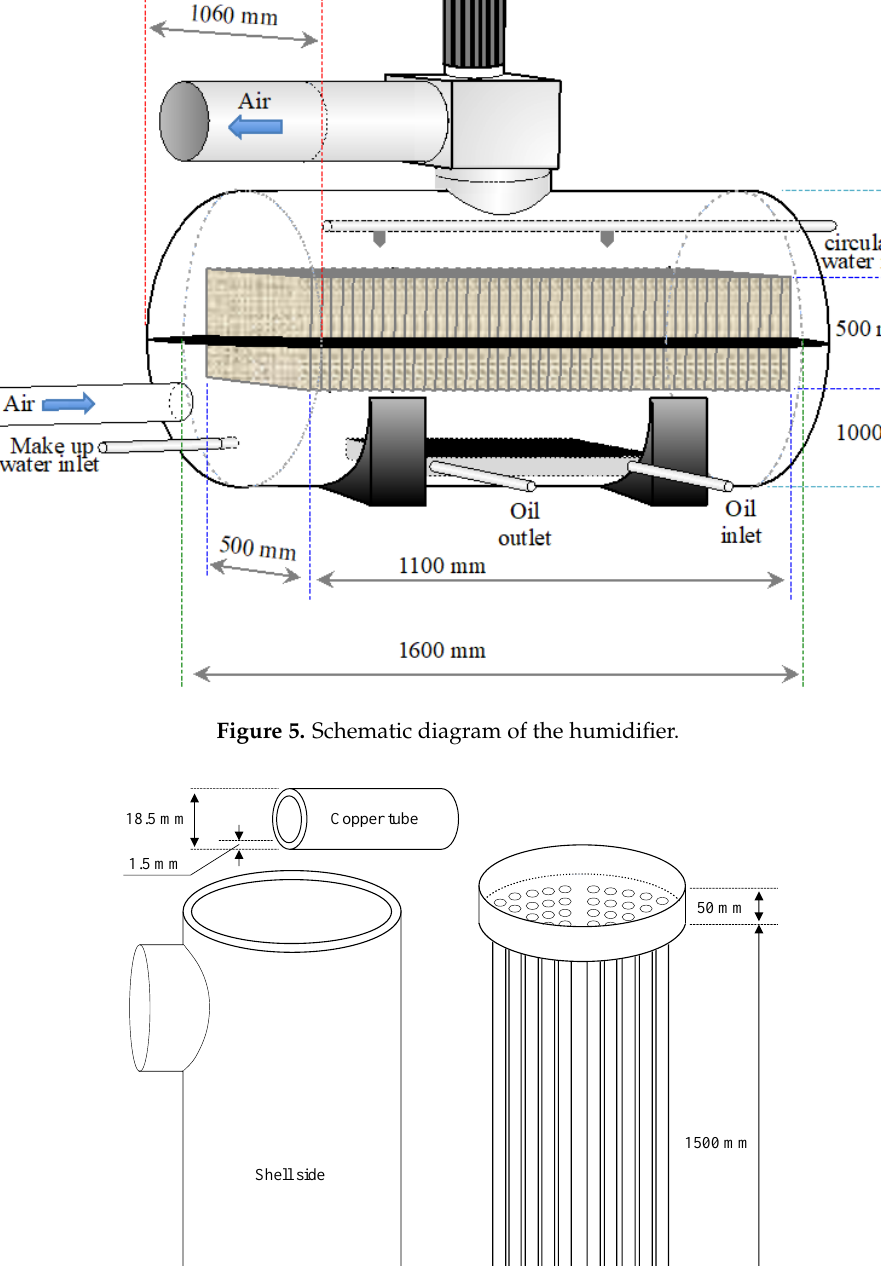
Figure 7. Schematic diagram of the experiment controls. The east and west rotations of PTCs are protected by limit switches, installed in both directions for controlling the motor operation at sunset, to return the PTCs to the home position and stop the motor when the home position is reached as well as prepare the collector for the sunrise position of the next day. An absolute type encoder, mounted on the DC motor shaft, controls the angular position of the PTCs to monitor the motion activity. The desalination unit drives and the circulating oil pump drive speed are controlled by an AC frequency inverter, which provides a wide range of speed control; hence, the flow capacities are controlled based on the desired testing value. The circulating water pump of the humidifier is kept at a constant speed, while the air circulating fan speed is altered. The system oil/air/water temperatures are measured using K-type thermocouples, which have a wide